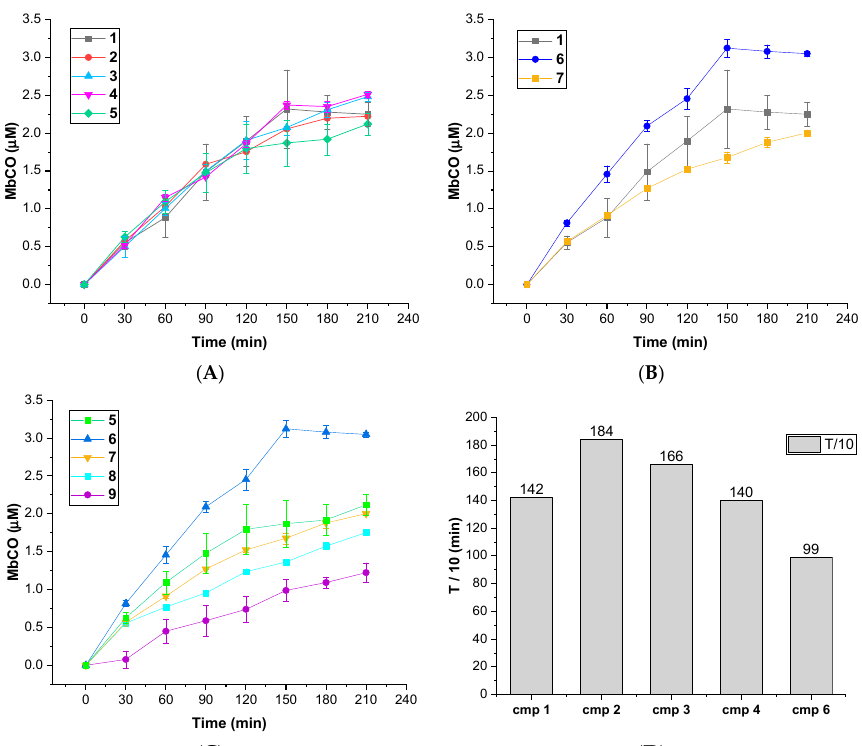
Figure 2. ( A – C ): CO-release profiles of compounds 1 - 9 as Mb-CO formed over time (1:6 CORM:Mb ratio); ( D ): T 1/10 values for compounds 1 - 4 and 6 (defined as the time necessary for a CORM solution to produce a Mb-CO concentration of 1/10 of the initial).